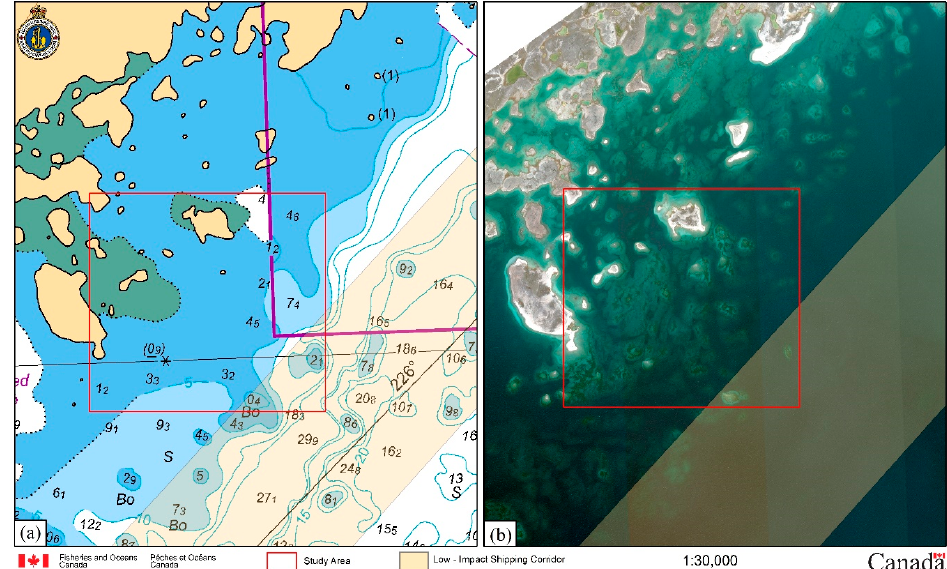
Figure 5. Outline of study site 2 near Taloyoak and the Northern Low-Impact Shipping Corridor in ( a ) Chart 7701 and ( b ) a WorldView-2 image acquired on August 13, 2017. ©2017, DigitalGlobe, Inc.